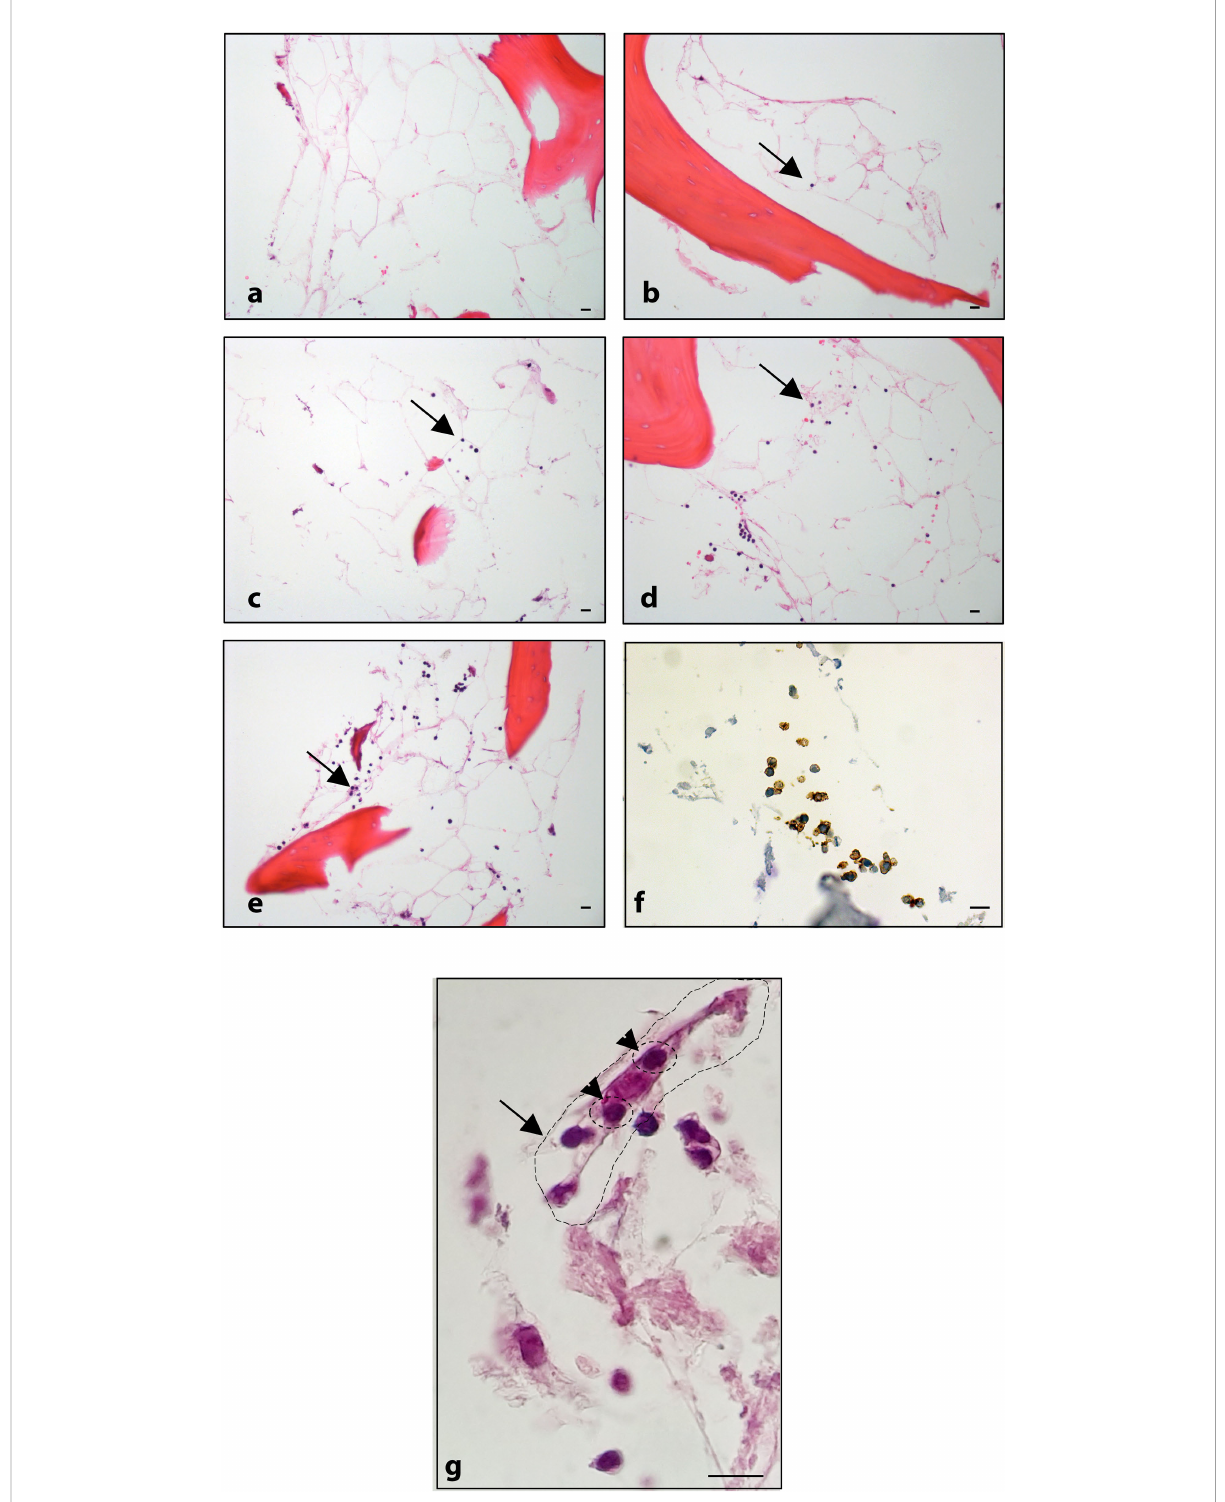
FIGURE 6 Histological analysis: (A) BM-MSC recellularized scaffold; ECM/MSC model after 1, 3, 6, and 8 days of incubation with OCI-LY18 ( B – E , respectively). (F) CD20 staining of OCI-LY18 adherent cells. (G) ECM/MSC model: arrow indicates a BM-MSC; head arrows indicate adherent neoplastic cells. Hematoxylin/eosin staining. Scale bars: 10 m